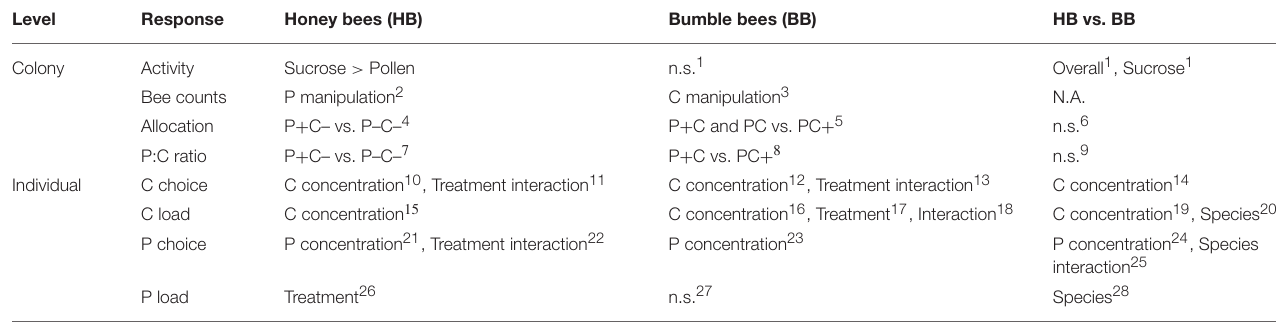
TABLE 3 | Summary of effects by treatment, diet concentration, bee species, and